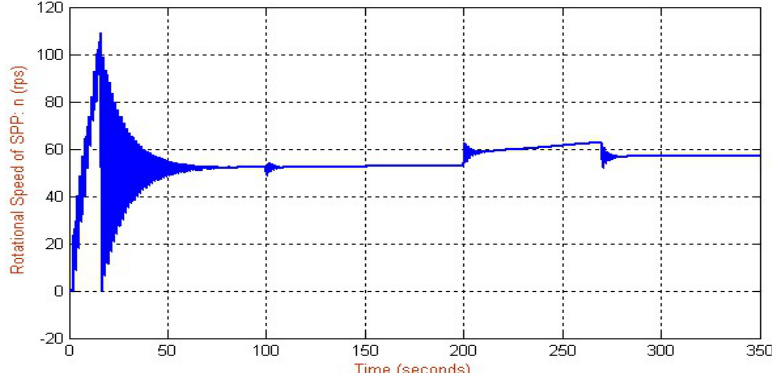
Figure 28. SPP rotational speed versus time.